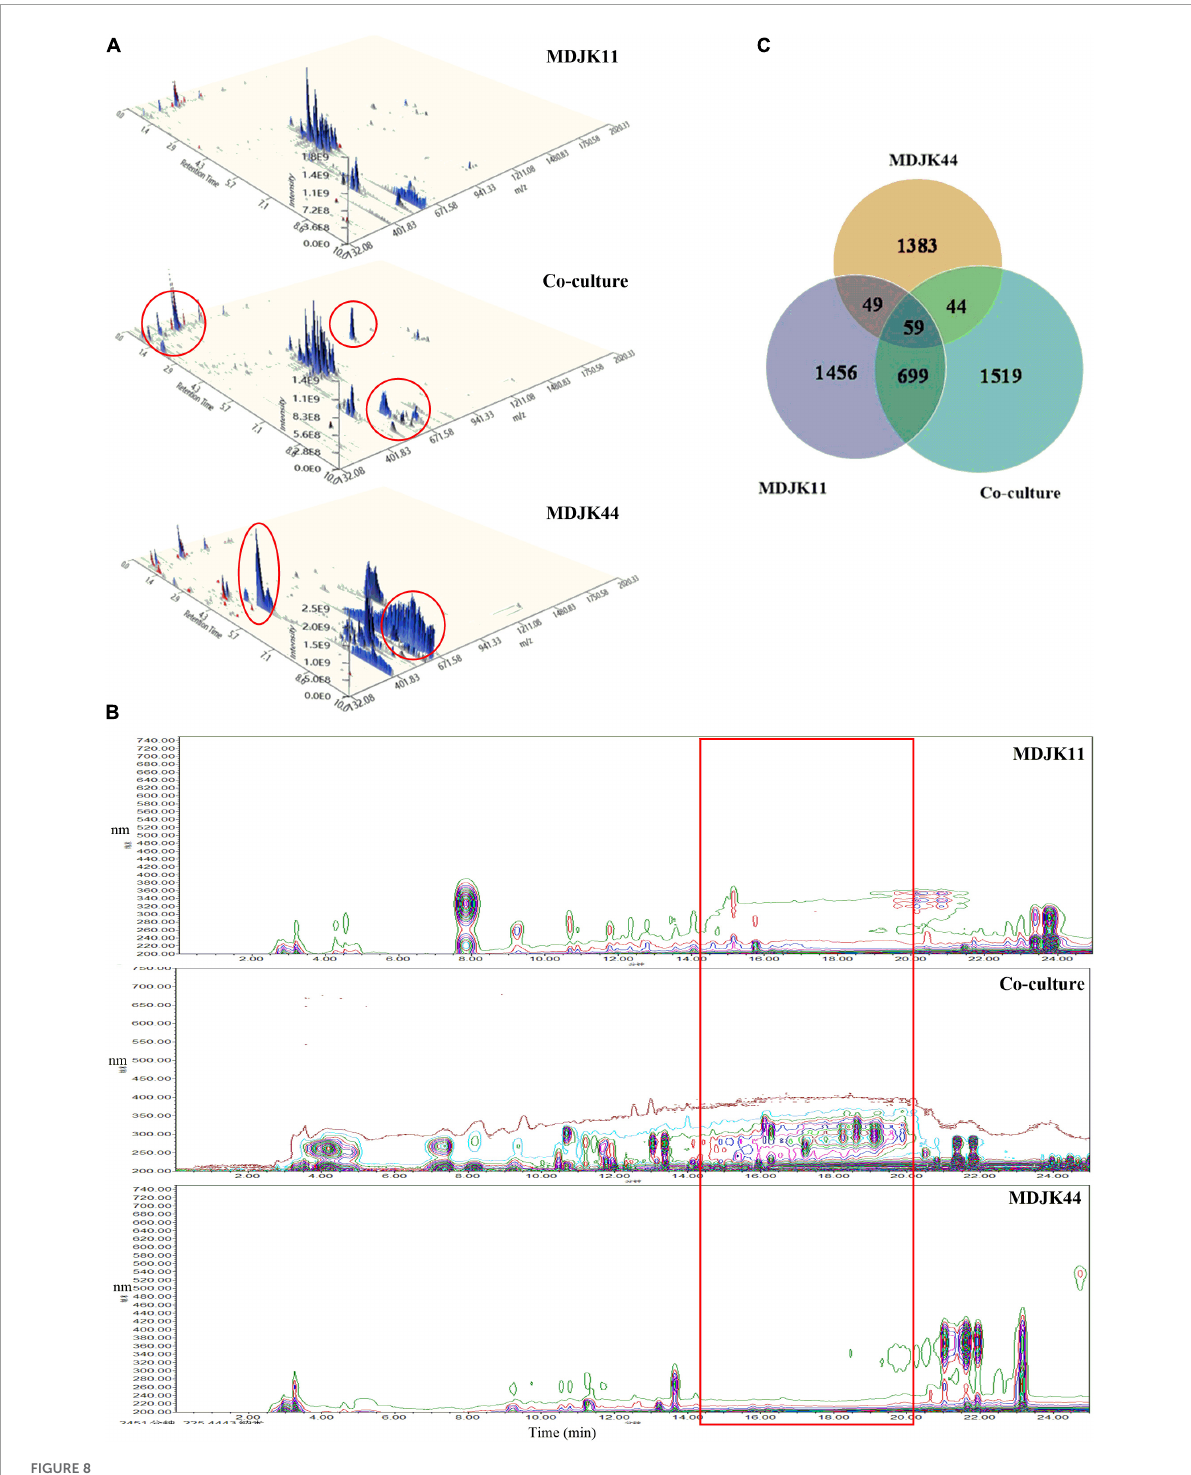
FIGURE8 The whole-ion scans (A) , HPLC fingerprint profiles (B) , and statistical Venn diagram of the identified metabolites (C) of Streptomyces MDJK11 and MDJK44 in monoculture and co-culture (the red circles represent the metabolic